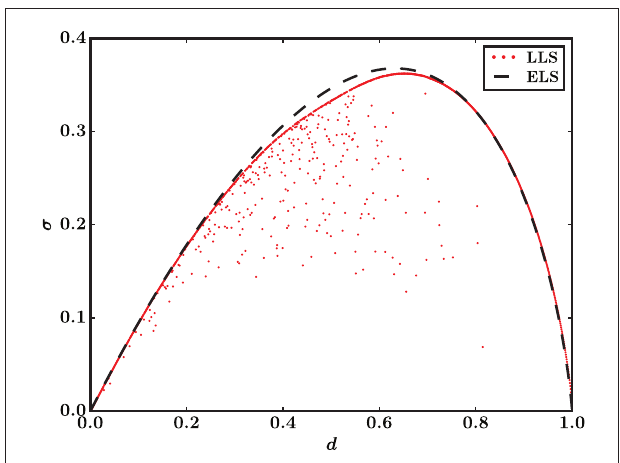
FIGURE 10 | Stress σ vs. damage d in the ELS model and the LLS model on a square lattice. The ELS curve has been calculated analytically via Equation (1), and the LLS result is a simulation of a single sample ( N = 1,024 2 ). For clarity, the LLS result shows only every 800th data point. The threshold distribution is P ( t ) = 1 − e − t for both models.